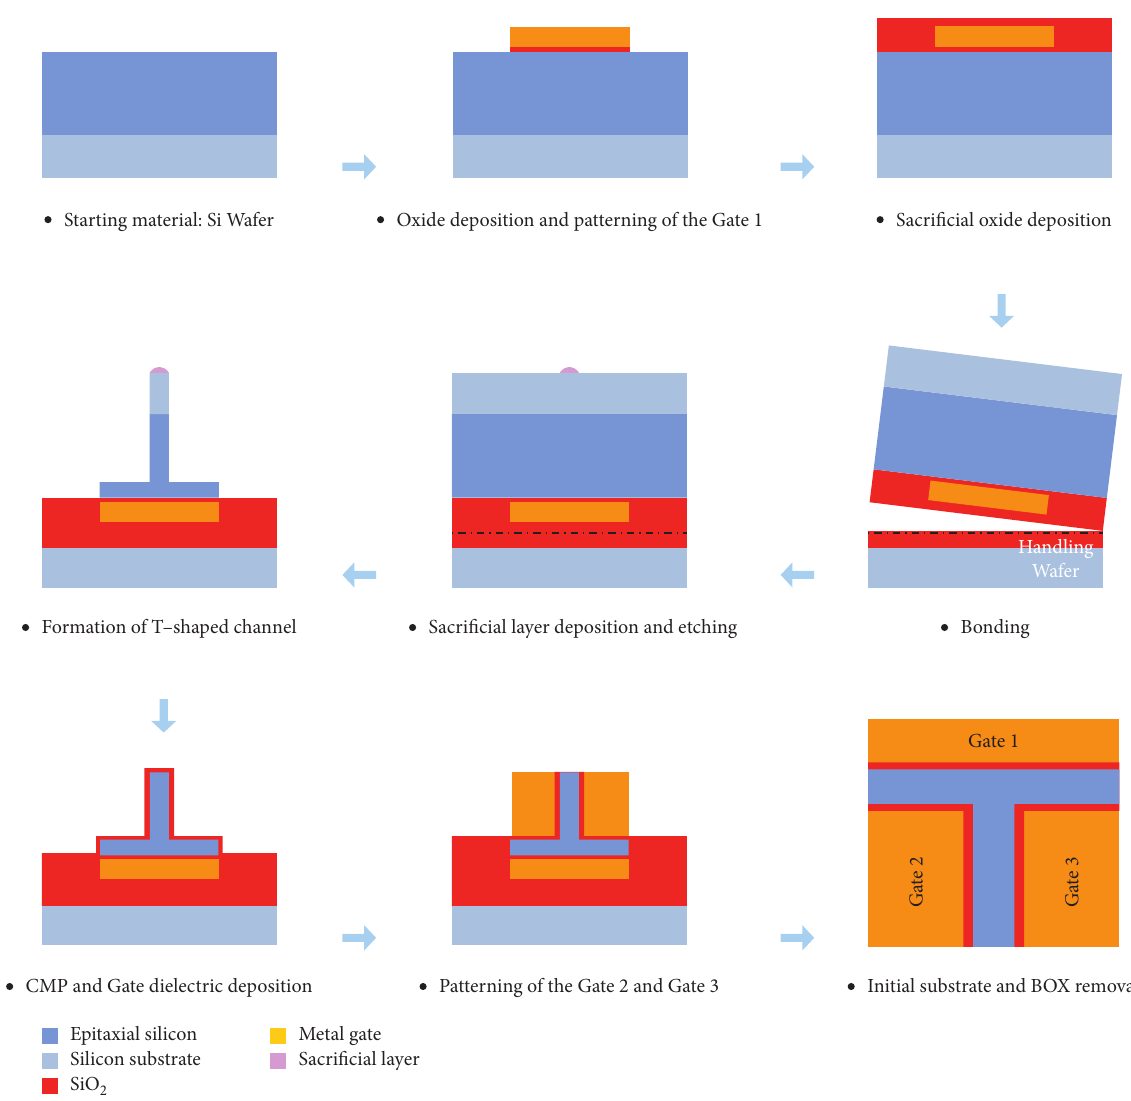
Figure 2: Main fabrication process flow of the